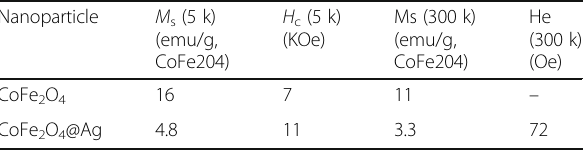
Table 1 Magnetic properties of CoFe 2 O 4 nanoparticles and CoFe 2 O 4 @Ag nanoparticles Nanoparticle